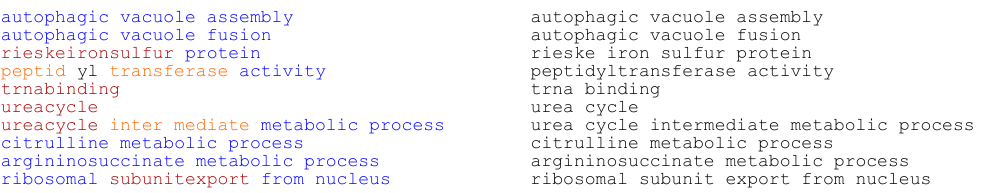
Figure 4: An excerpt of the test data which shows the word breaking results compared with the original file. Correctly segmented terms are labelled blue and wrong segmentations are labelled red Orange words are not completely identical with the original text but also not wrong.